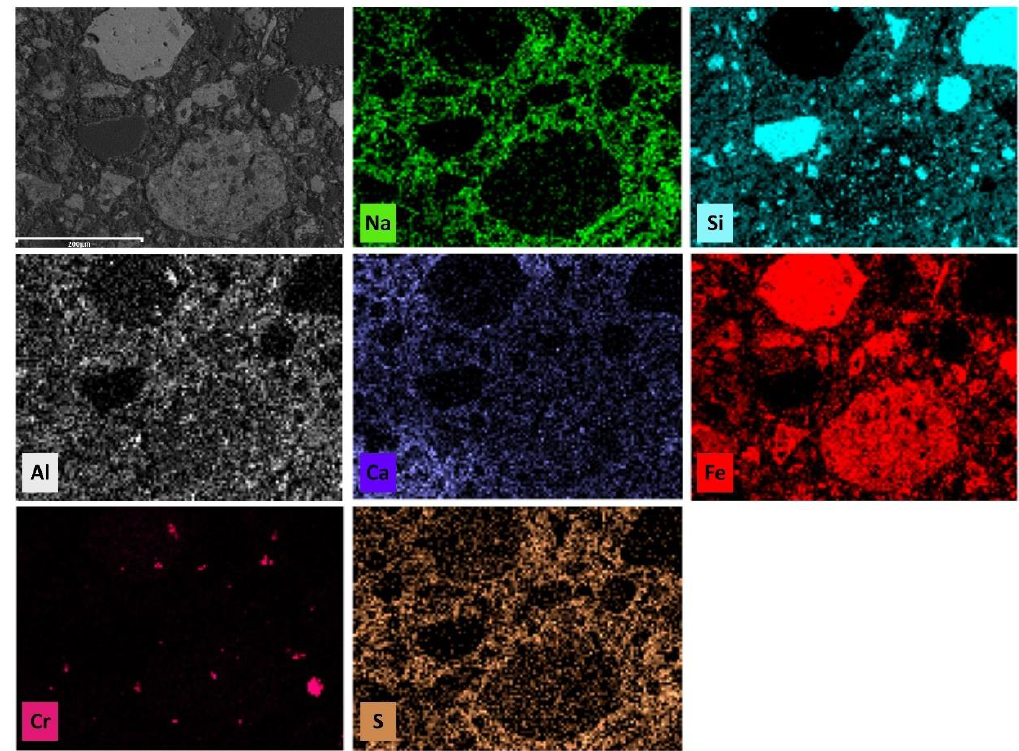
Figure 10. Elemental mapping analysis of LR90MK10 AAM produced by mixing laterite residues and metakaolin at mass ratio 90:10.